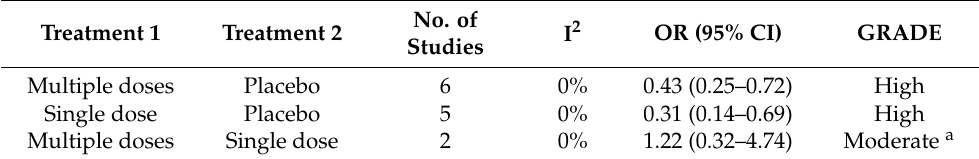
Table 2. Meta-analysis results for pairwise comparisons of steroid administration frequency. Treatment